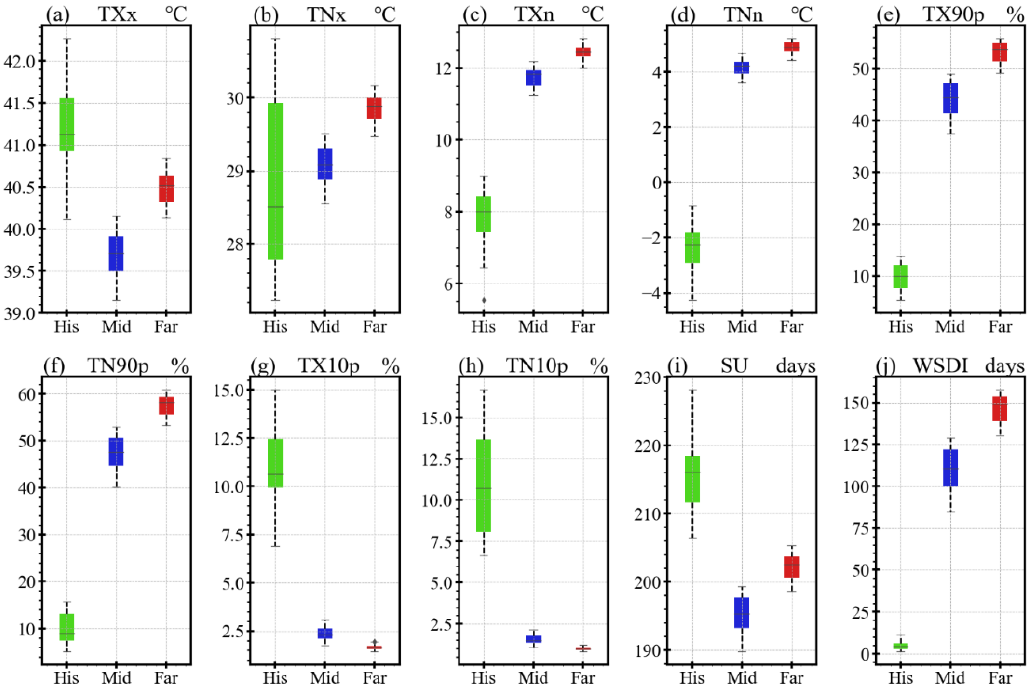
Figure 15. Projected changes in extreme temperature spatially averaged over the study domain during the mid- (2041–2070) and far-future (2071–2100) relative to the baseline period (1995–2014) for the SSP2-4.5 scenario. The indices reflect the intensity (TXx, TNx, TXn and TNn) ( a – d ), frequency (TX90p, TN90p, TX10p, and TN10p) ( e – h ) and duration (SU and WSDI) ( i , j ) of the extreme events. For each box plot, the horizontal line represents the median and central uncertainty range of the temperature index across the CMIP6 MME. The whiskers extend to the 10 and 90% uncertainty range.